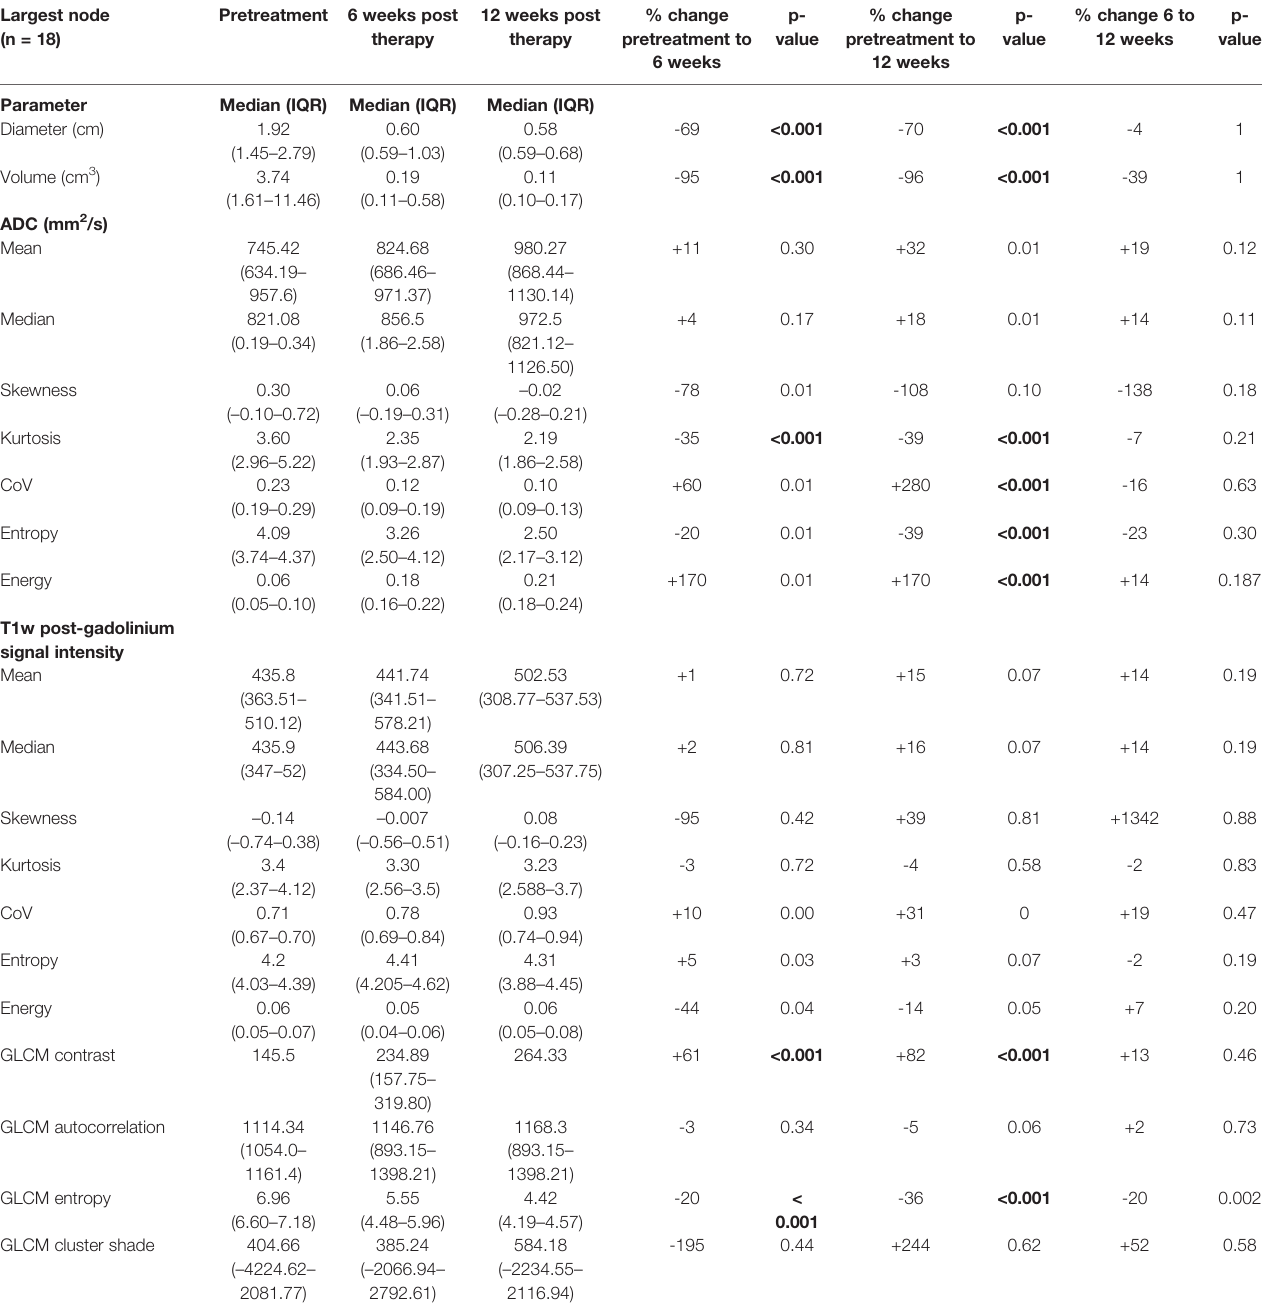
TABLE 3 | Pretreatment, 6-week post-CRT and 12-week post-CRT ADC and post-gadolinium T1w texture parameters and their interval changes in metastatic lymph nodes of participants with treatment response (n =